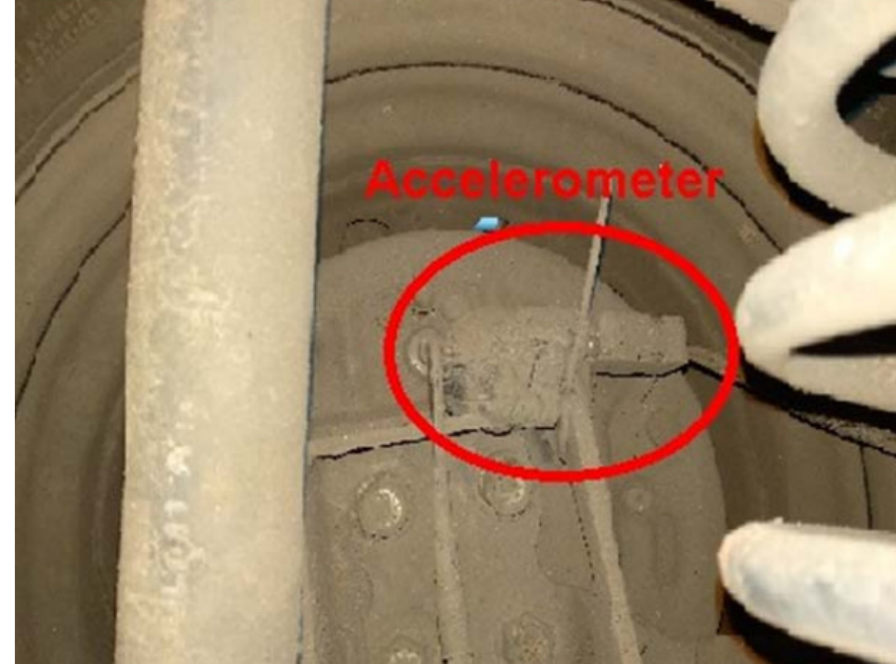
Figure 3. MEMS Accelerometer mounted on the test vehicle’s rear axle.